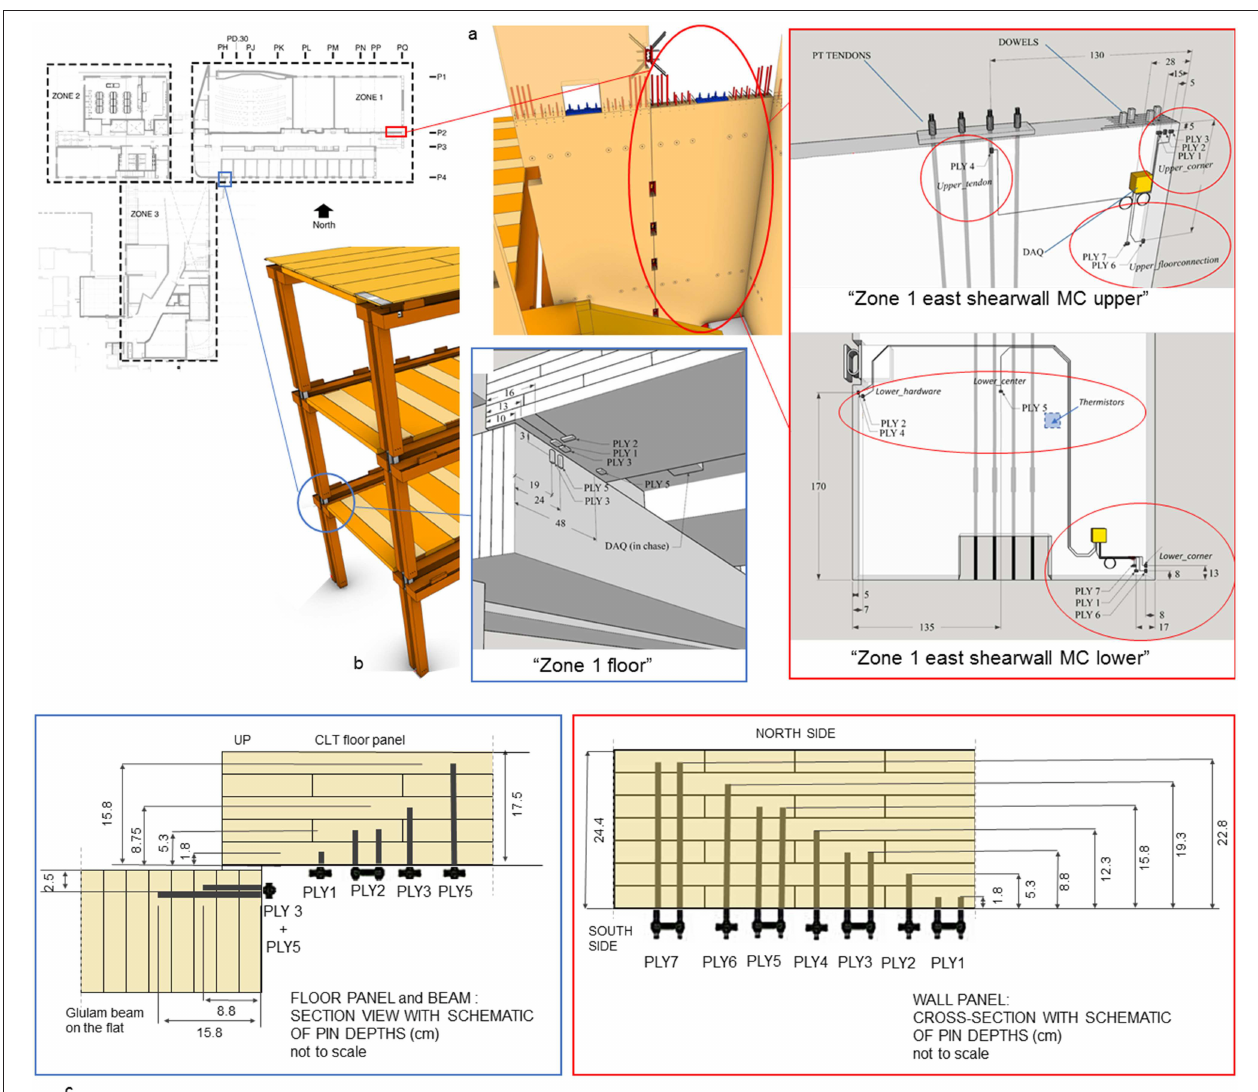
FIGURE 1 | Plan of Peavy Hall with location of monitored locations (a) shear wall; (b) floor; (c) schematic with pin depth of MC sensors.